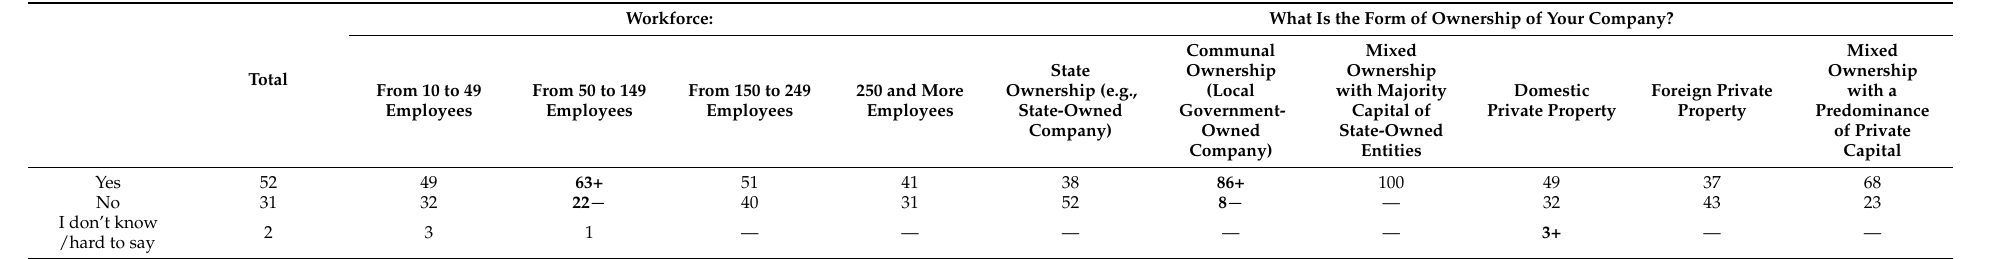
Table 4. Are the EU plans to reduce CO 2 to zero and make the European economy emission-free (European Green Deal) too costly for countries such as Poland? (in percentage points).